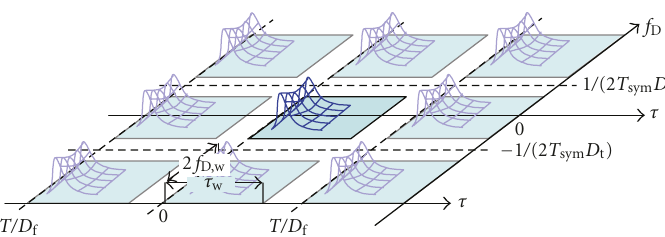
Figure 4: Filter transfer function of an ideal 2D low-pass interpolation